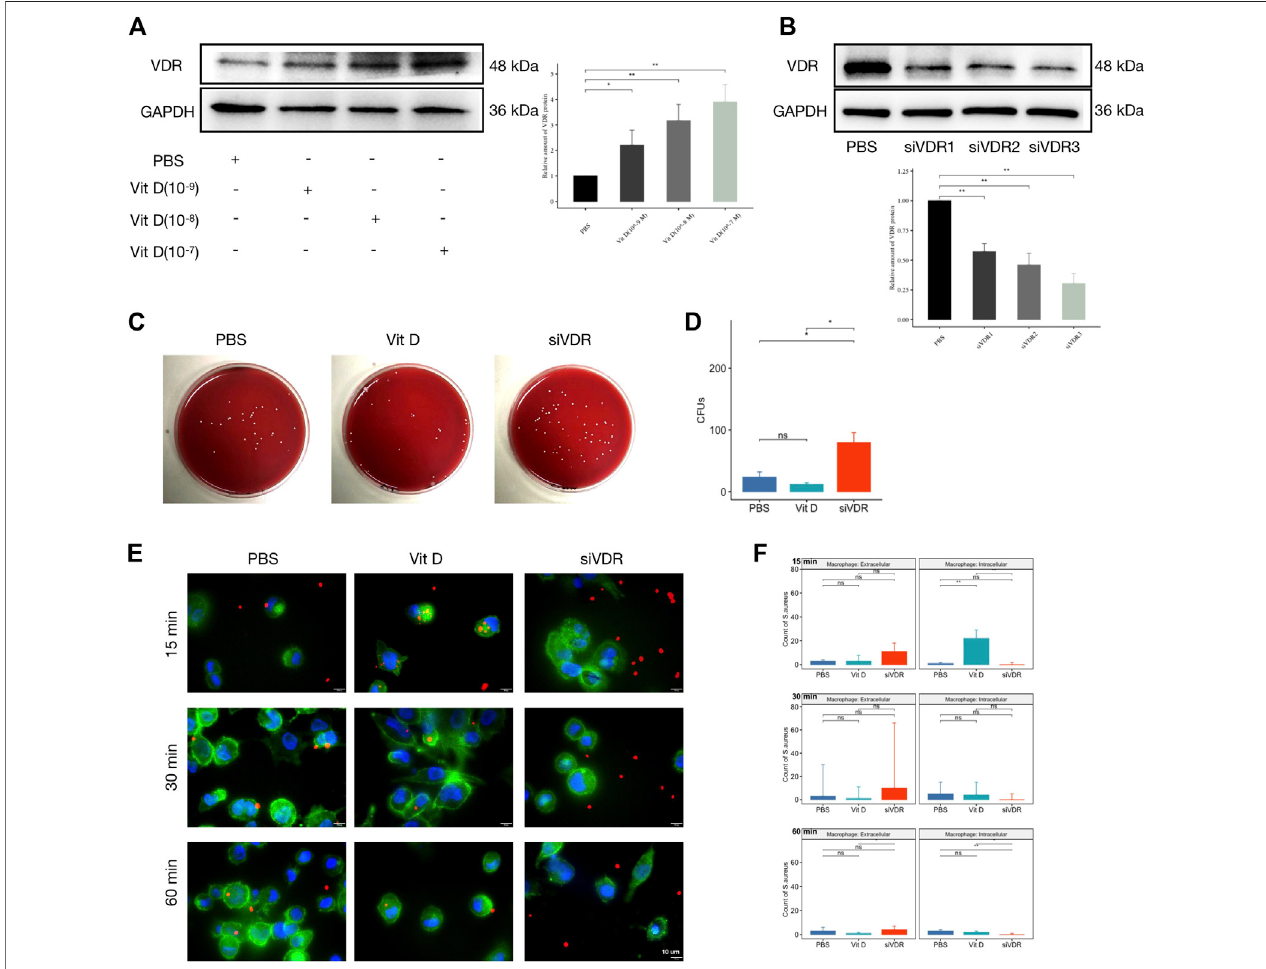
FIGURE 3 | Vitamin D enhanced macrophage phagocytosis and bactericidal ability. (A) Active vitamin D gradient promoted VDR protein expression. (B) siRNAs inhibitedthe expression ofVDR protein, and the inhibitory effect ofsiVDR3 was themost obvious. (C) Representative images after coating the plate with overexpression or knockdown of VDR protein levels. (D) CFUs of 1 hour after bacterial infection. (E) Double immuno fl uorescence staining for S. aureus (red) and F-Actin (cytoskeleton, green). Magni fi cation, ×2,000. (F) Count of S. aureus intracellular or extracellular. “ ns ” for not signi fi cant, * p < 0.05, ** p < 0.01, and *** p < 0.001.